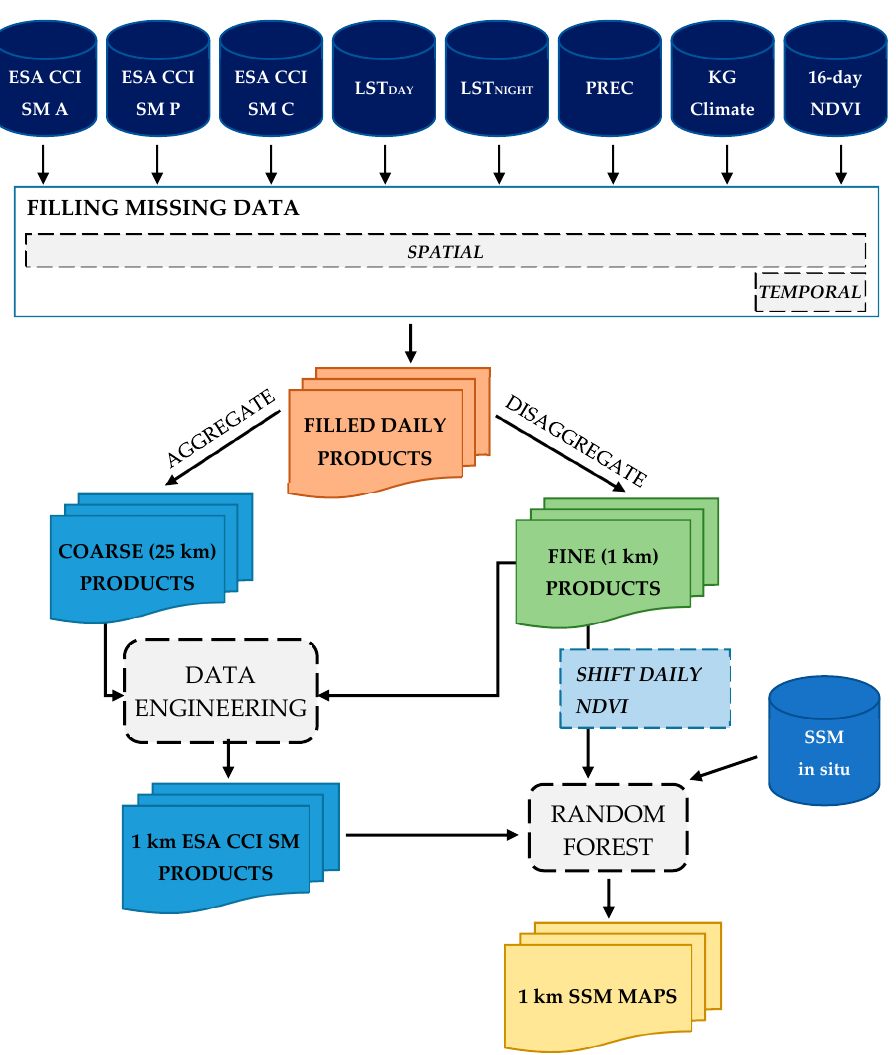
Figure 3. The flowchart diagram of the data processing steps.